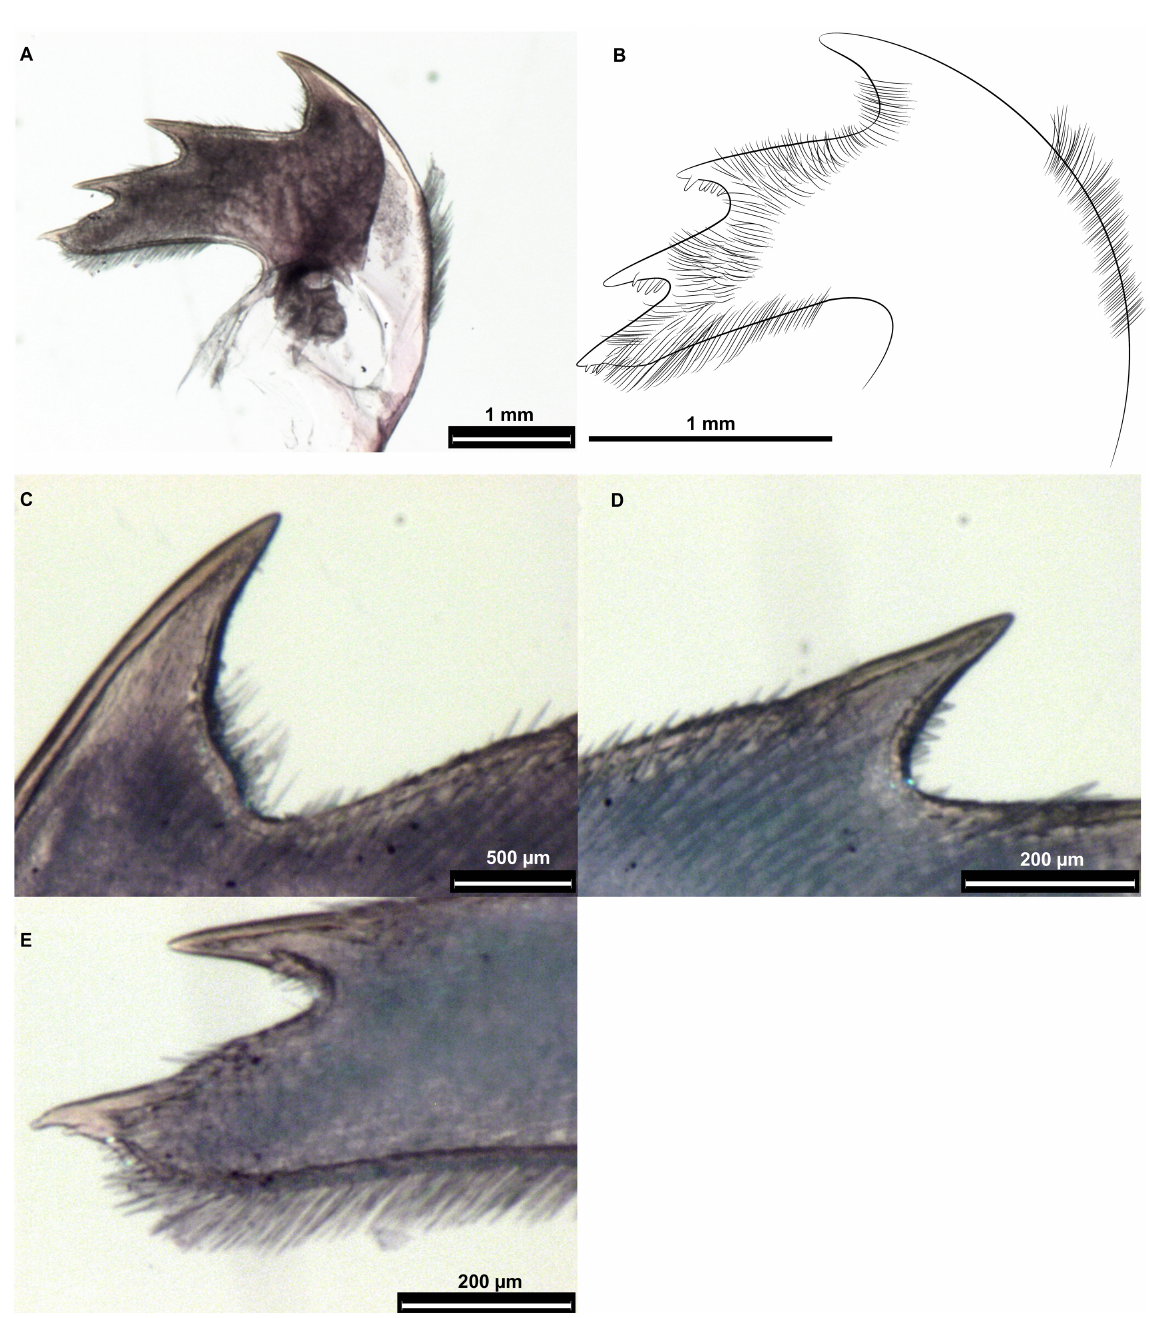
Fig. 3. Line drawings and pictures of the mouth parts of Heteralepas gettysburgensis sp. nov. (holotype) A–B . Mandible. C . Tooth I. D . Tooth II. E . Tooth III. F . Tooth